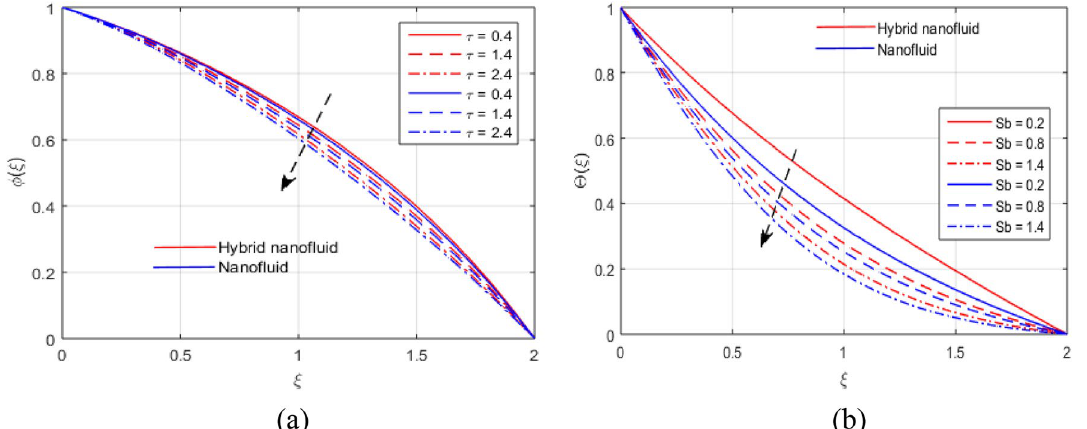
Figure 15. ( a , b ) Effect of τ and Lb on φ(ξ) and �(ξ) .